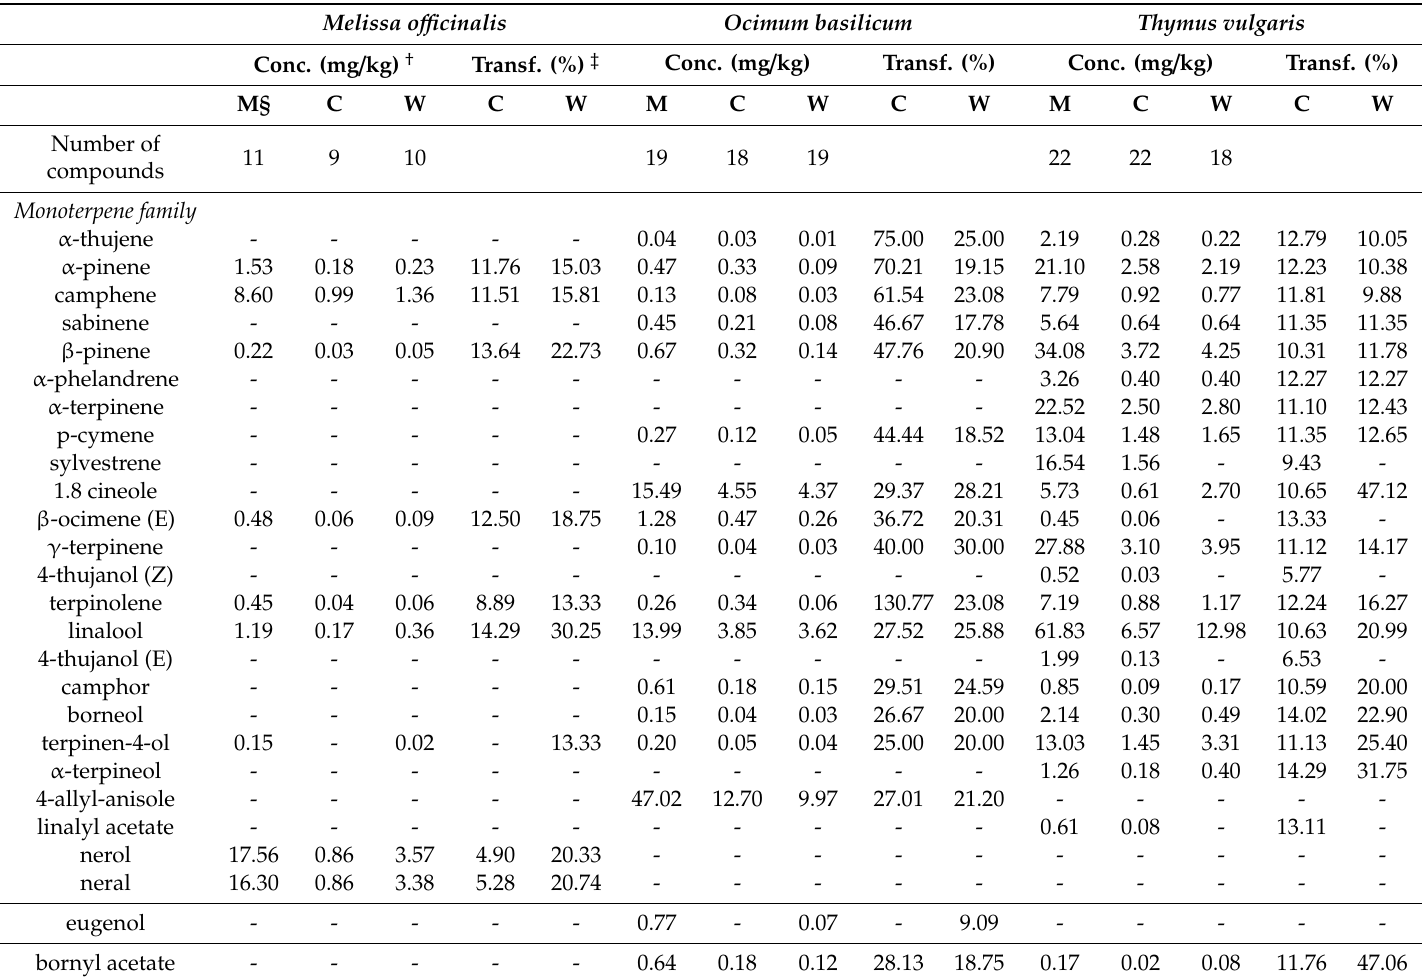
Table 2. Presence of compounds in fortified dairy products and transfers from milk to cheese and whey ( n =